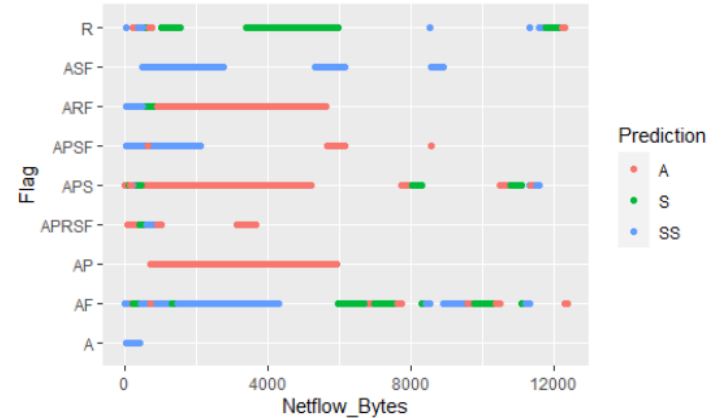
Figure 39. Cyclostationarity of zero-day threats in the UGRansome